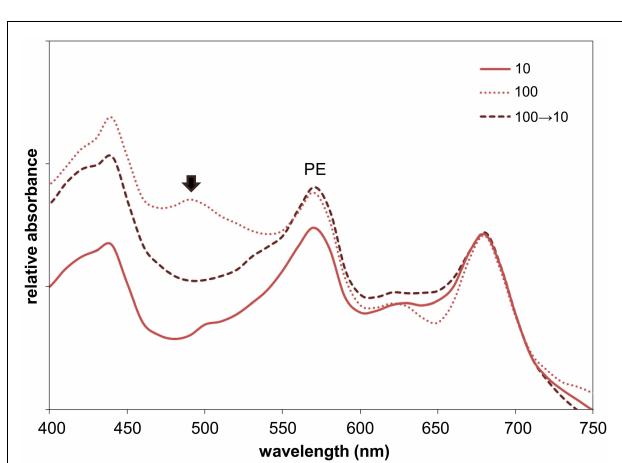
FIGURE 2 | Confocal laser scanning microscopy analyses of cellular morphology of Fremyella diplosiphon UTEX 481 wild-type (WT) strain under green light (GL) conditions of varying light intensity. F. diplosiphon WT was grown in BG-11 culture medium containing 20mM HEPES at 10, 50, 75, or 100 μ molm − 2 s − 1 (numbers indicated at left) at 28˚C with shaking at ∼ 175rpm as indicated in Figure 1 . Representative